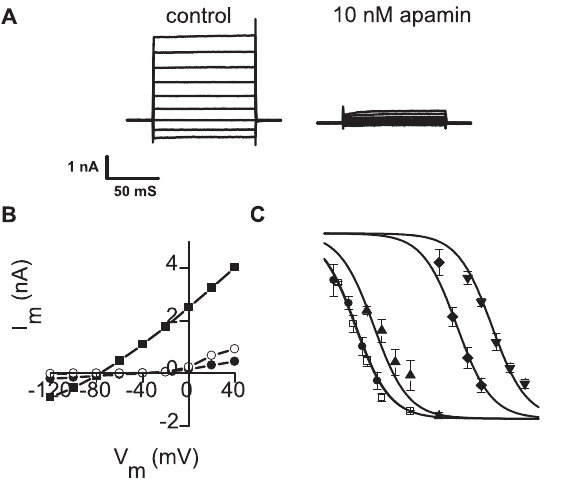
Figure 5. Effects of apamin and known K Ca 2 inhibitors on K Ca 2.2 current. A Typical current record from a HEK 293 cell transiently transfected with K Ca 2.2. In control solution (left panel) robust, time-independent currents are seen. Application of 10 nM apamin causes a very substantial reduction (right panel). B Current N voltage relationships for the cell in A in the absence ( & ) and presence ) of 10 nM apamin. In the absence of apamin the current reverses at ( 2 80 mV, close to the predicted value of E K . In the presence of apamin the residual current is similar to that seen in an untransfected HEK 293 cell ( # ) suggesting that at this concentration apamin causes nearly N complete inhibition of K Ca 2 current. C Concentration inhibition curves ), UCL 1848 ( % ), UCL 1684 ( m ), dequalinium ( X ) and for apamin ( gallamine ( . ). Each point is the mean of 3–5 observations, vertical bars Figure 6. The effect of the ionic composition of bathing show s.e.m. Fitted lines were drawn from the Hill equation with a solution on the potency of apamin. Representative recordings of common Hill slope of 0.7 6 0.04 (see Methods). Note that the curves K Ca 2 current in HEK 293 cells transiently transfected with K Ca 2.2. The drawn for apamin and UCL 1848 overlie each other. At sufficiently high recordings were made in standard solution (A), nominally Ca 2 + and concentrations of blocker near complete inhibition of current is Mg 2 + free solution (B) and Na + , Mg 2 + and Ca 2 + free solution in which achieved. The IC 50 values calculated for each compound are given in NaCl was replaced by 280 mM sucrose (C). In each case the left panel Table 1. shows currents recorded before and the right panel after the application of 100 pM apamin. D Summary of data for the inhibition caused by 100 pM apamin in the solutions used in A, B and C. Vertical bars show s.e.m. * denotes that the values were significantly different from the effect of apamin in standard solution (p , 0.05, unpaired t-test). E Concentration-inhibition curve for apamin applied in Ca 2 + and Mg 2 + free solution. Each point is the mean of 3–5 observations with vertical bars indicating s.e.m. The solid line was drawn from a fit of the Hill equation with IC 50 = 20 6 3 pM and n =0.8 6 0.06. The dashed line represents the concentration-inhibition curve for apamin in standard solution shown in Figure 4.